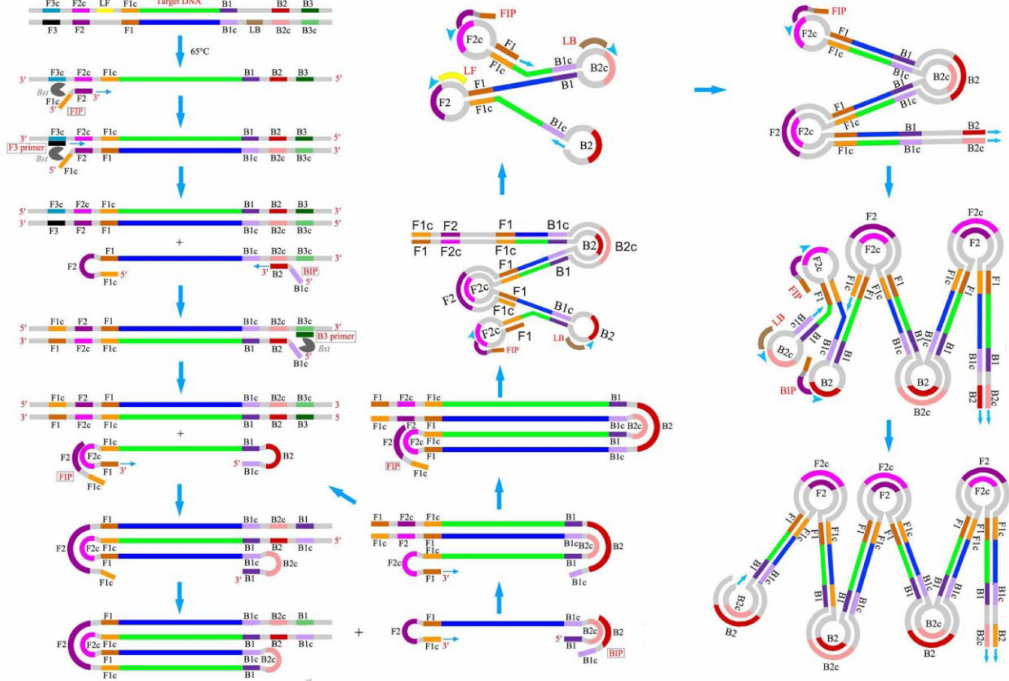
Figure 1. Schematic of LAMP mechanism. Reproduced with permission from reference [24], open access. Copyright 2016 Frontiers